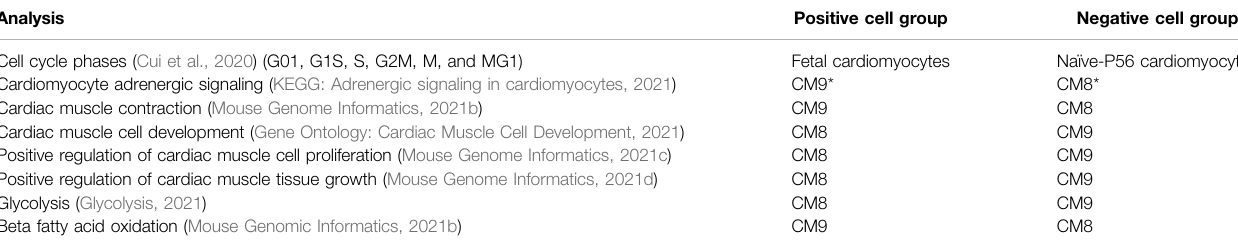
TABLE 2 | Positive and negative cell groups for Sparse analysis.